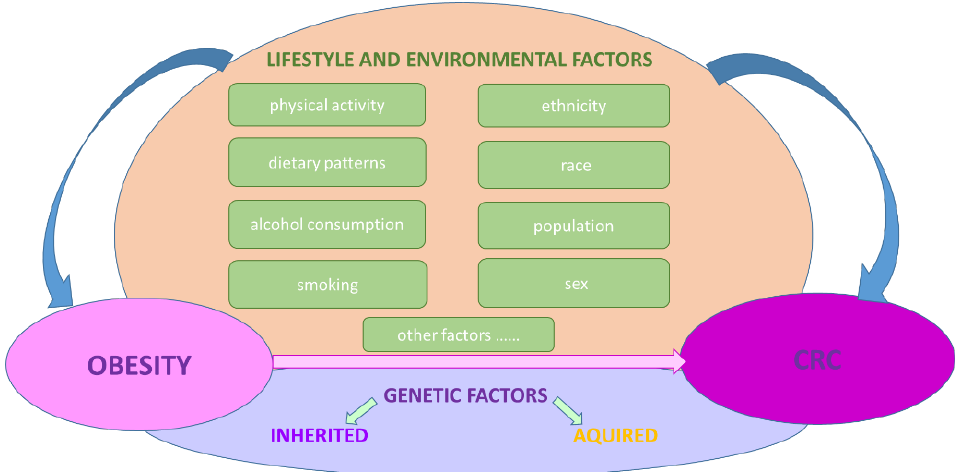
Figure 1. Factors influencing obesity and CRC risk.